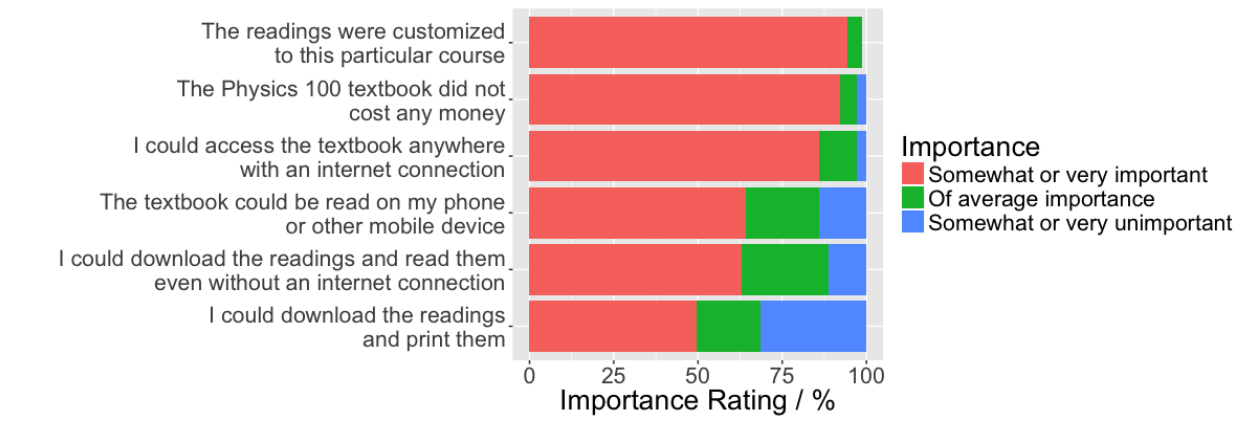
Figure 3 . How respondents rated the importance of various features of the Physics 100 open textbook. 7 N=143. See Appendix C for percentages for each